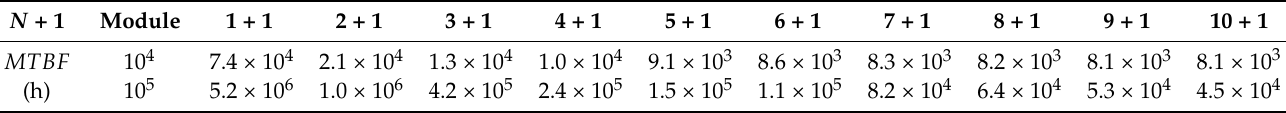
Table 1. Derating design parameters of key